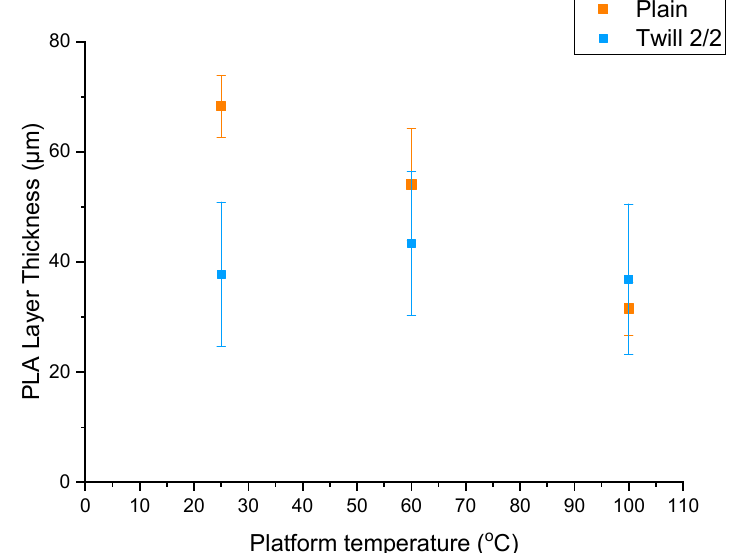
Figure 13. Poly lactic acid (PLA) track thickness ( µ m) depending on the platform temperature of the 3D printer (25, 60 and 100 ◦ C) for plain fabrics (in orange) and twill fabric (in